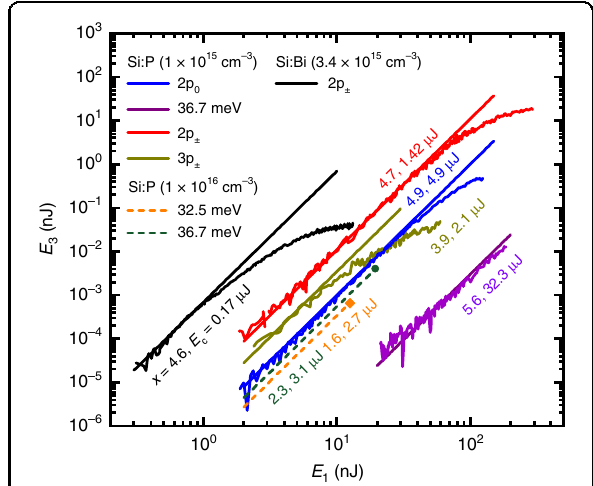
Fig. 2 Internal DFWM conversion ef fi ciency for different samples, both on and off resonance. The different doping densities ( n D ) and samples are given in the legend. Each curve is labelled by either the laser photon energy ( (cid:1) h ω in meV) or the resonant transition being excited. The ratio between pump pulse energies x = E 2 / E 1 was kept constant in each case: values of x are given on each data set. The data = E 2 as expected), and the solid lines are very close to cubic ( E 3 ¼ x 2 E 3 1 c are fi ts to the low intensity portion. The fi tted values of E c are also indicated. For the high density Si:P sample, only one intensity was measured at each laser frequency and a cubic dependence (dashed lines) is shown for comparison with the other